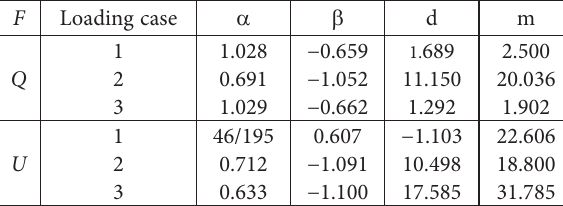
Table 3. The fitted parameters of Eqn (16)